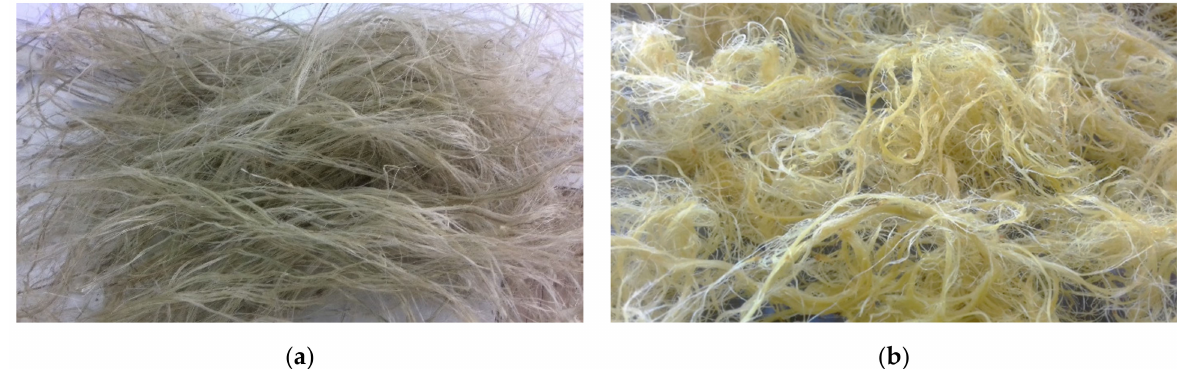
Figure 2. ( a ) Dry Spanish broom fibers treated with seawater; ( b ) drying Spanish broom fibers treated with 5% NaOH.